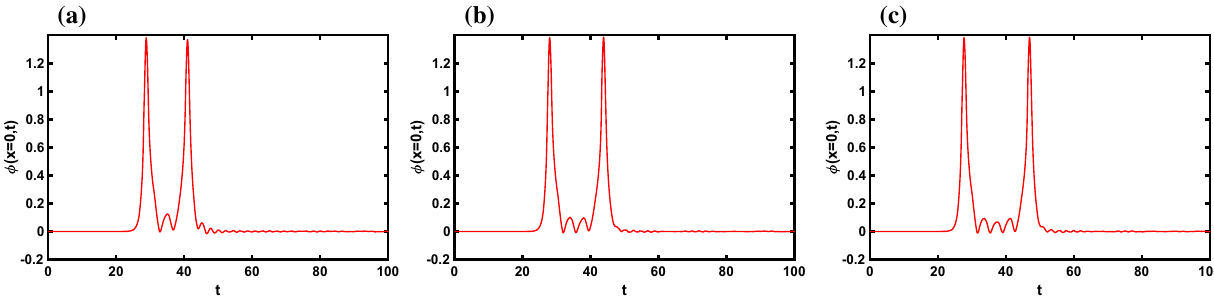
Fig. 15 Antikink-kink scattering: Scalar field φ( x = 0 , t ) at the collision center as a function of time for three consecutive two-bounce windows for n = 3 with a v = 0 . 41, b v = 0 . 423 and c v = 0 . 428